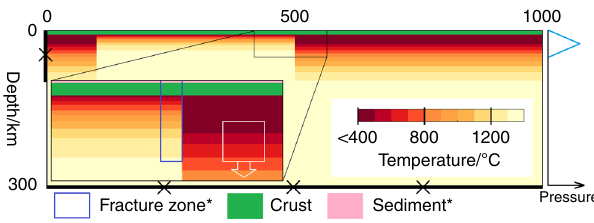
Fig. 5 Schematic of the model setup and initial thermal condition. Thermal boundary conditions are as the initial thermal condition (top boundary is at 0 °C and ambient mantle is 1350 °C). Mechanically, the top boundary is a free surface and the bottom closed and non-slip. The left (Philippine) side is closed and non-slip above 80 km and open below. The right (Paci fi c) side is open but an additional pressure can be added above 50 km to facilitate the application of an external push force. The schematic graph to the right of the fi gure is of the envelope of this applied pressure. Crust and sediment layers make up the top 7 and 1 km of the model domain initially and this material is tracked. The white box outlines the region to which the additional pull force is applied. * “ fracture zone ” material (outlined by the blue box) and sediment are initialised the maximum amount of “ damage ” (see main